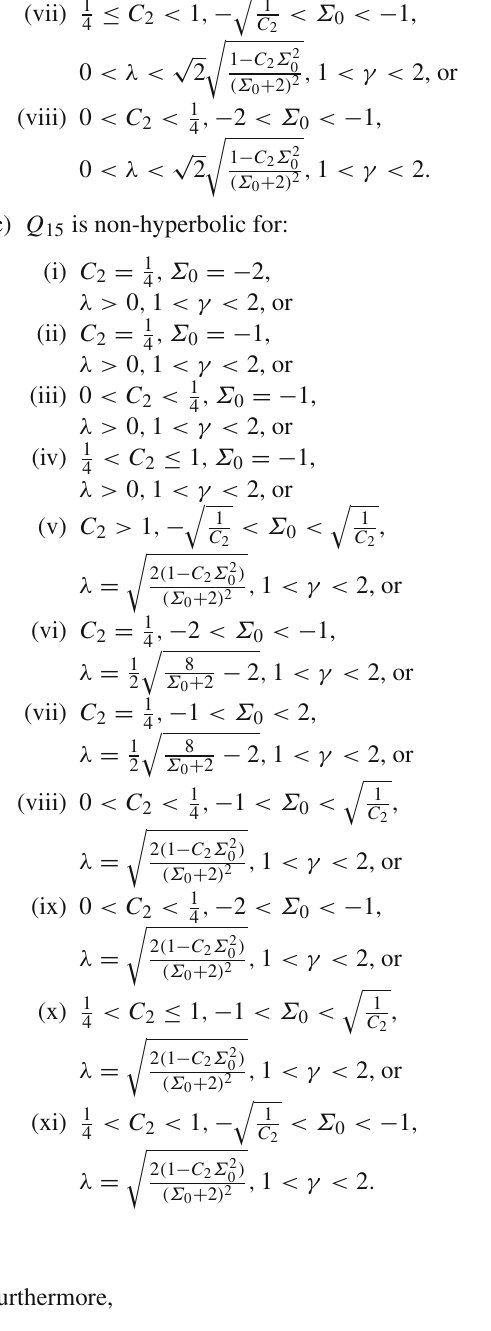
value is zero and the other three eigenvalues are the